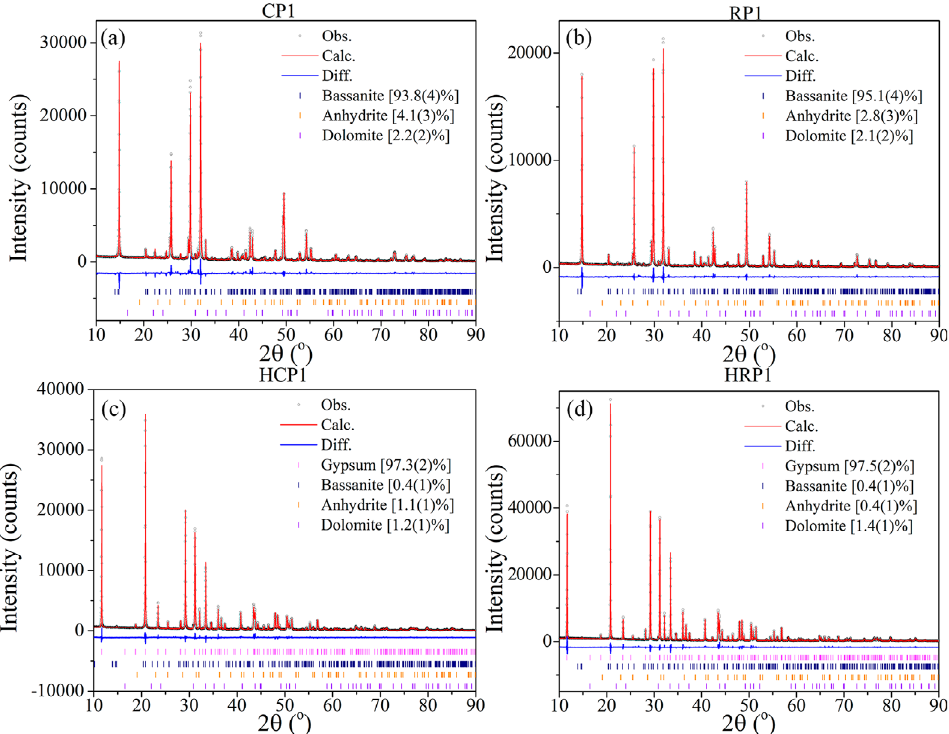
Figure 1. Rietveld plot and quantitative phase analysis of samples (a) CP1, (b) RP1, (c) HCP1, and (d) HRP1. The open circles represent the observed data, the red line represents the calculated values, and the blue line is the difference between the calculated and observed data. Vertical bars represent the peak positions of each phase.